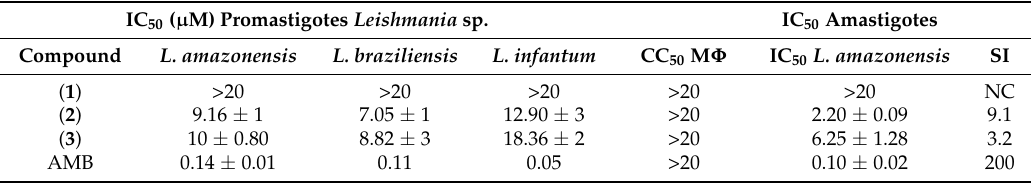
Table 1. In vitro pharmacological activity of dimeric flavonoids.